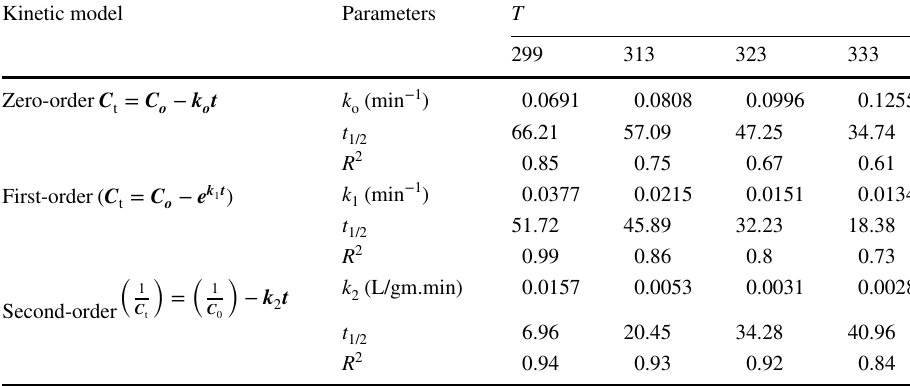
Table 4 Kinetic parameters for different reaction order models for BB9 treatment in aqueous